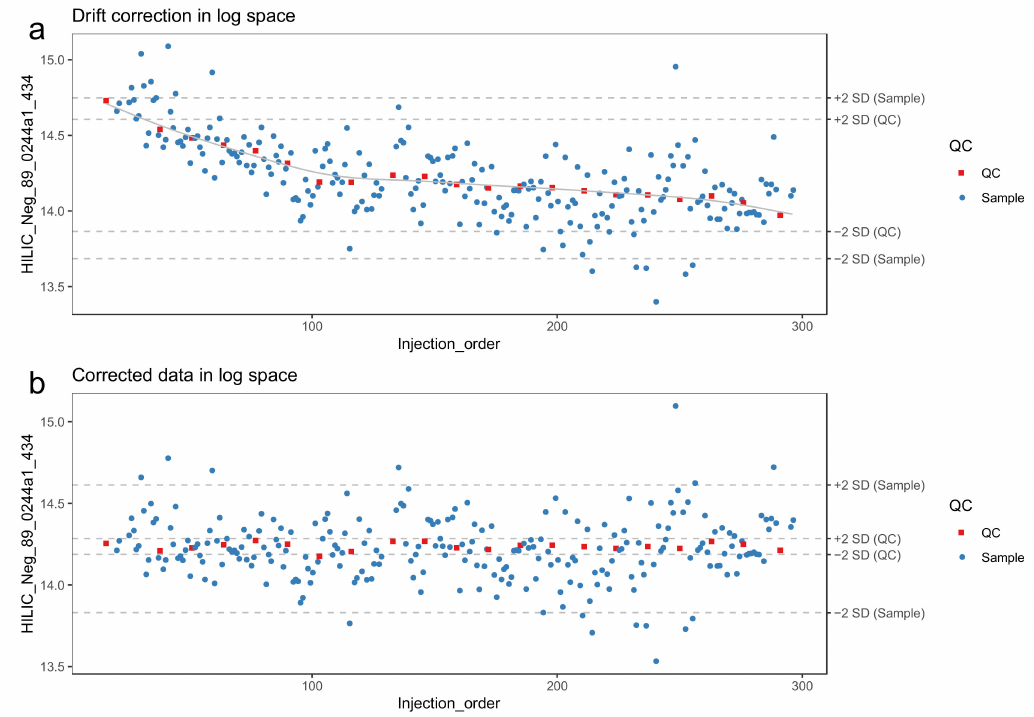
Figure 3. A molecular feature before ( a ) and after ( b ) drift correction by smoothed cubic spline regression. The horizontal lines represent 2 standard deviations from the mean of quality control (QC) samples and biological samples, respectively. The systematic e ff ect of the drift is reduced upon